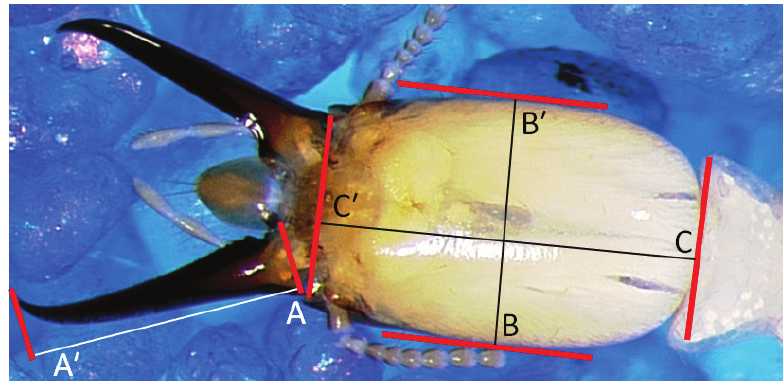
Figure 1. Cephalic metrics: AA' = maximum length of mandible; BB' = maximum width of head; CC' = length of head to lateral base of mandibles. Parallels used to delineate metrics (see Suppl. mate- rial 1) are marked in red.